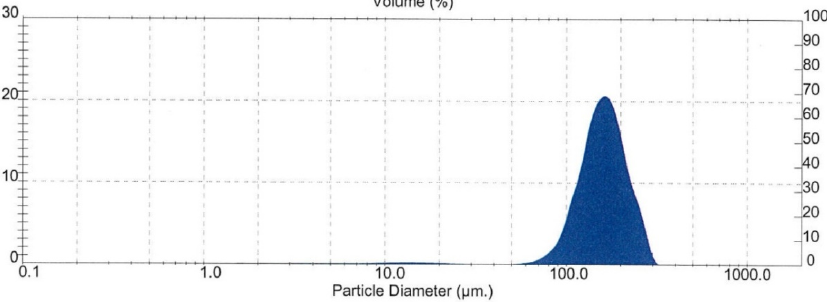
Figure 8. Particle size distribution of the sample after attritioning (feed for Flotation Test‒3).